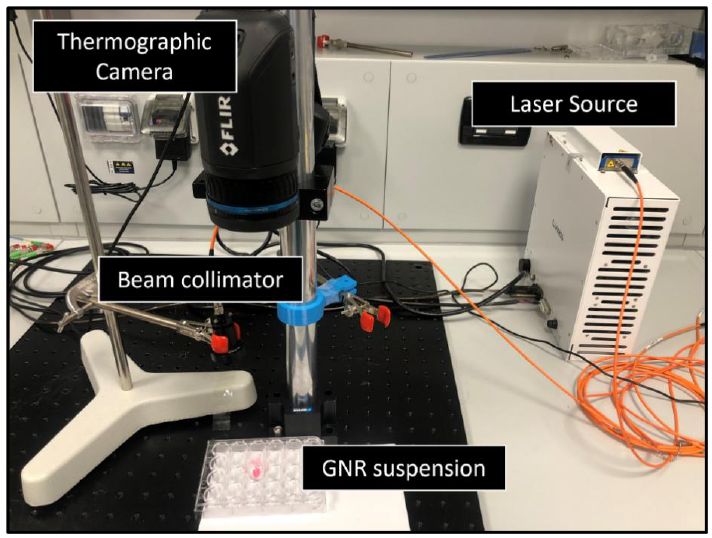
Figure 4. Experimental setup utilized for the near-infrared irradiation of GNR suspensions: the attained temperature results are used for the benchmark of the implemented simulation model.